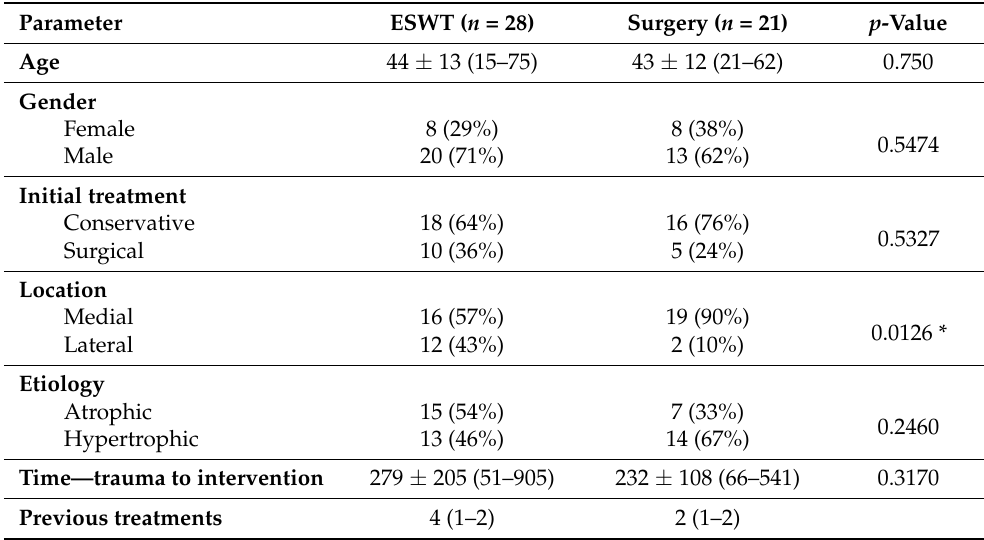
Table 1. Patients’ demographics and fracture details. The p -value indicates statistical significance between the ESWT and Surgical groups.